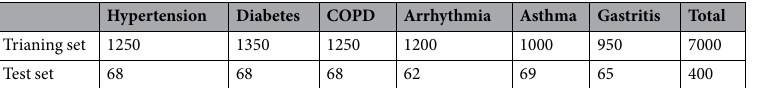
Table 1. The number of electronic medical records of each disease in the training set and test set, and the percentage of test data relative to training data of each disease.